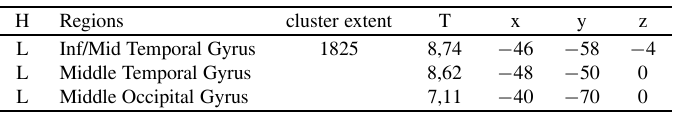
Table 1 Results of 99mTc –ECD SPECT in the two patients. Voxel-based analysis with SPM99 (Wellcome Department of Cognitive Neurology, Londra, UK) imple- mented inMATLAB6.1(Mathworks, Sherbon, MA).Comparisons between each patient and a control group (19 subjects) were made using t -statistics with ap- propriate linear contrasts. The tables report clusters above a statistical threshold set at p < 0.05 FWE corrected in MNI (Montreal Neurological Institute) space. A : patient L.P.; B : patient R.R.; H : hemisphere Regions cluster extent Inf/Mid Temporal Gyrus 1825